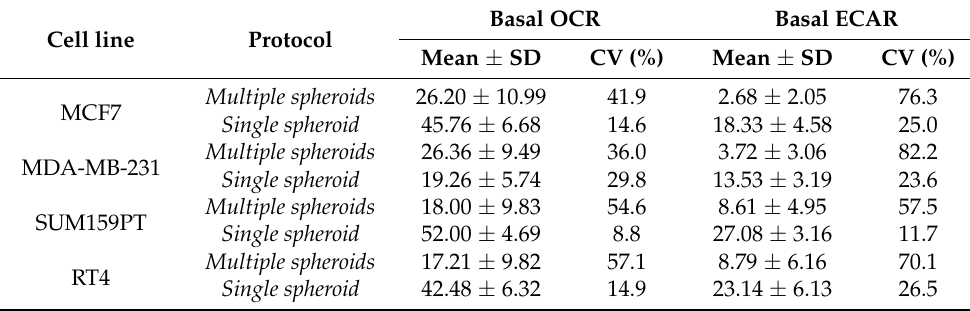
Table 2. Mean, standard deviation (SD), and the Coefficient of Variation (CV) of Basal Oxygen Consumption Rate (OCR) and Basal Extracellular Acidification Rate (ECAR) measured on spheroids formed with the Multiple Spheroids Protocol and Single Spheroid Protocol in four cancer cell lines: MCF7, MDA-MB-231, SUM159PT, and RT4. Cell